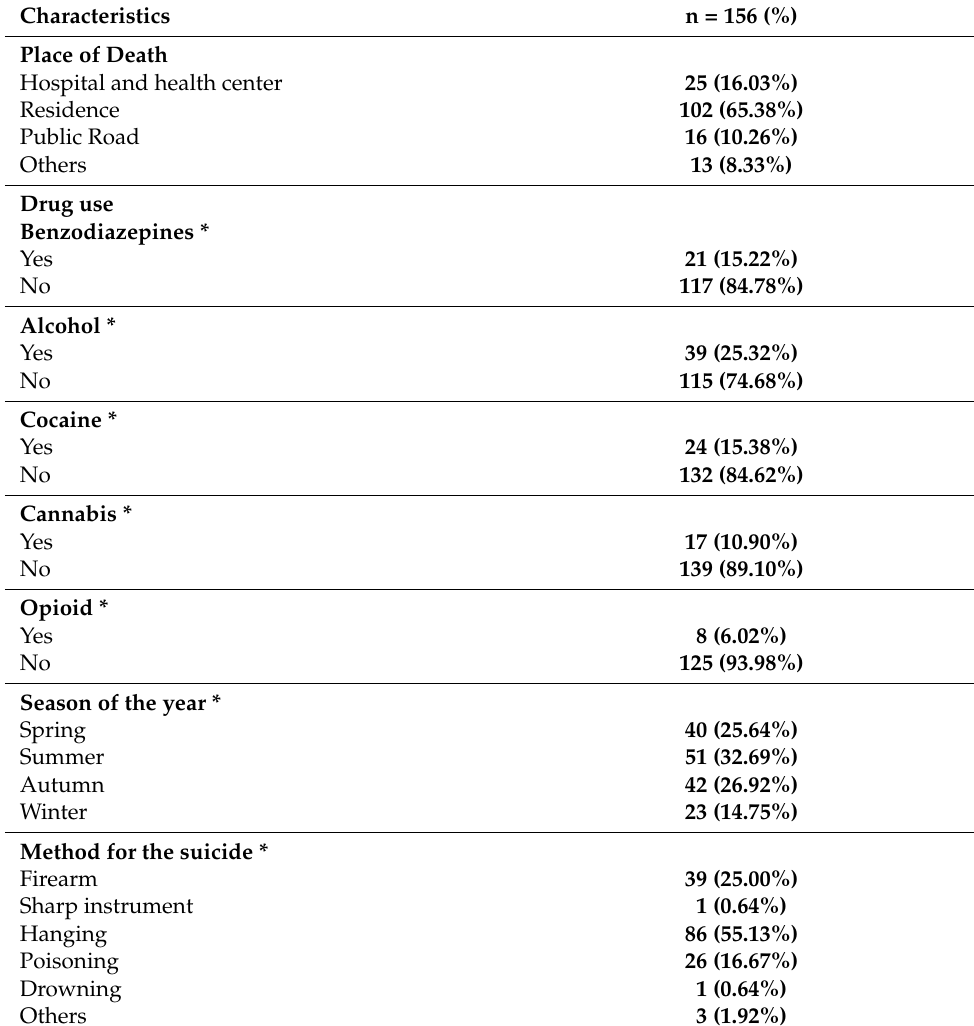
Table 2. Drug used and death characteristics of suicide victims.